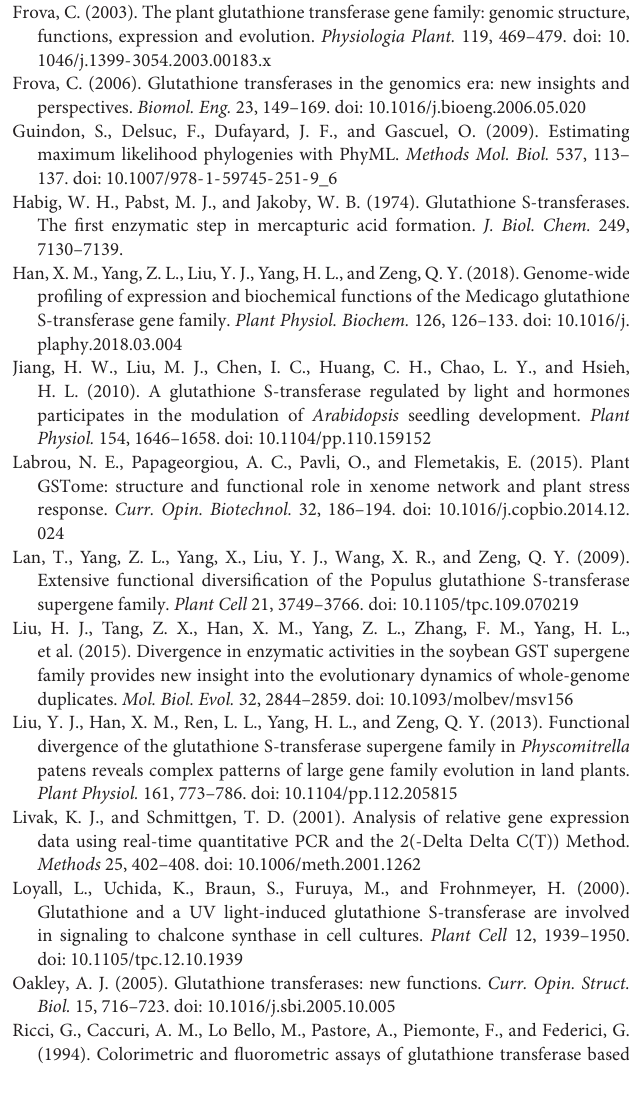
TABLE S3 | Primers used to construct the protein expression